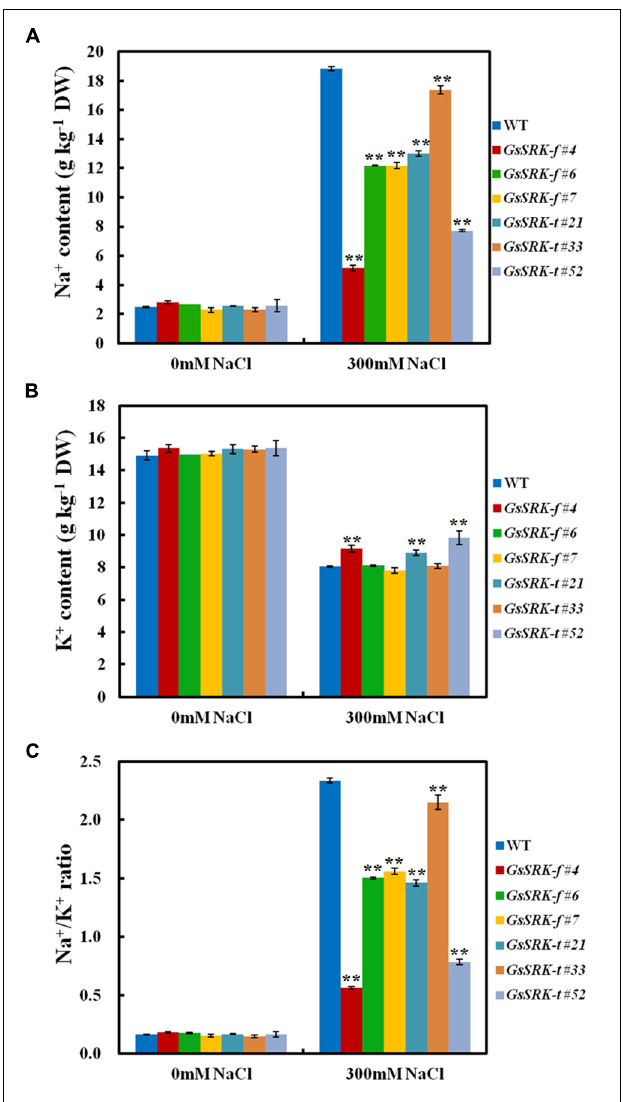
FIGURE 5 | GsSRK overexpression facilitates to maintain the Na + /K + balance under salt stress. (A) The Na + contents of the WT and transgenic alfalfa under control conditions and salt stress. (B) The K + contents of the WT and transgenic alfalfa under control conditions and salt stress. (C) The Na + /K + ratio of the WT and transgenic alfalfa under control conditions and salt stress. Data are means ± SE ( n ≥ 3) of three replicates. ∗∗ P < 0.01 by Student’s t -test.